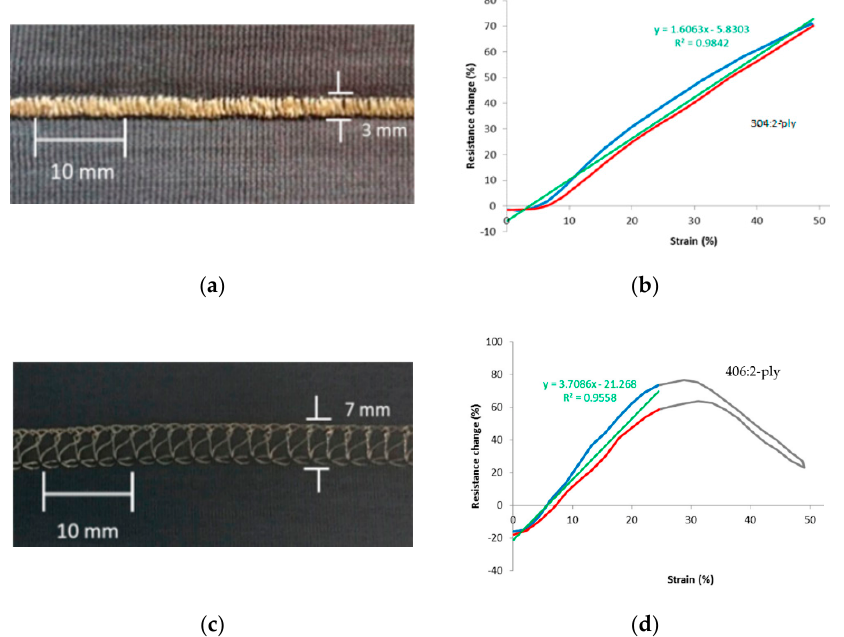
Figure 20. ( a ) Zigzag stitch and ( b ) corresponding resistance plot; ( c ) Coverstitch and ( d ) corresponding resistance plot [42] .